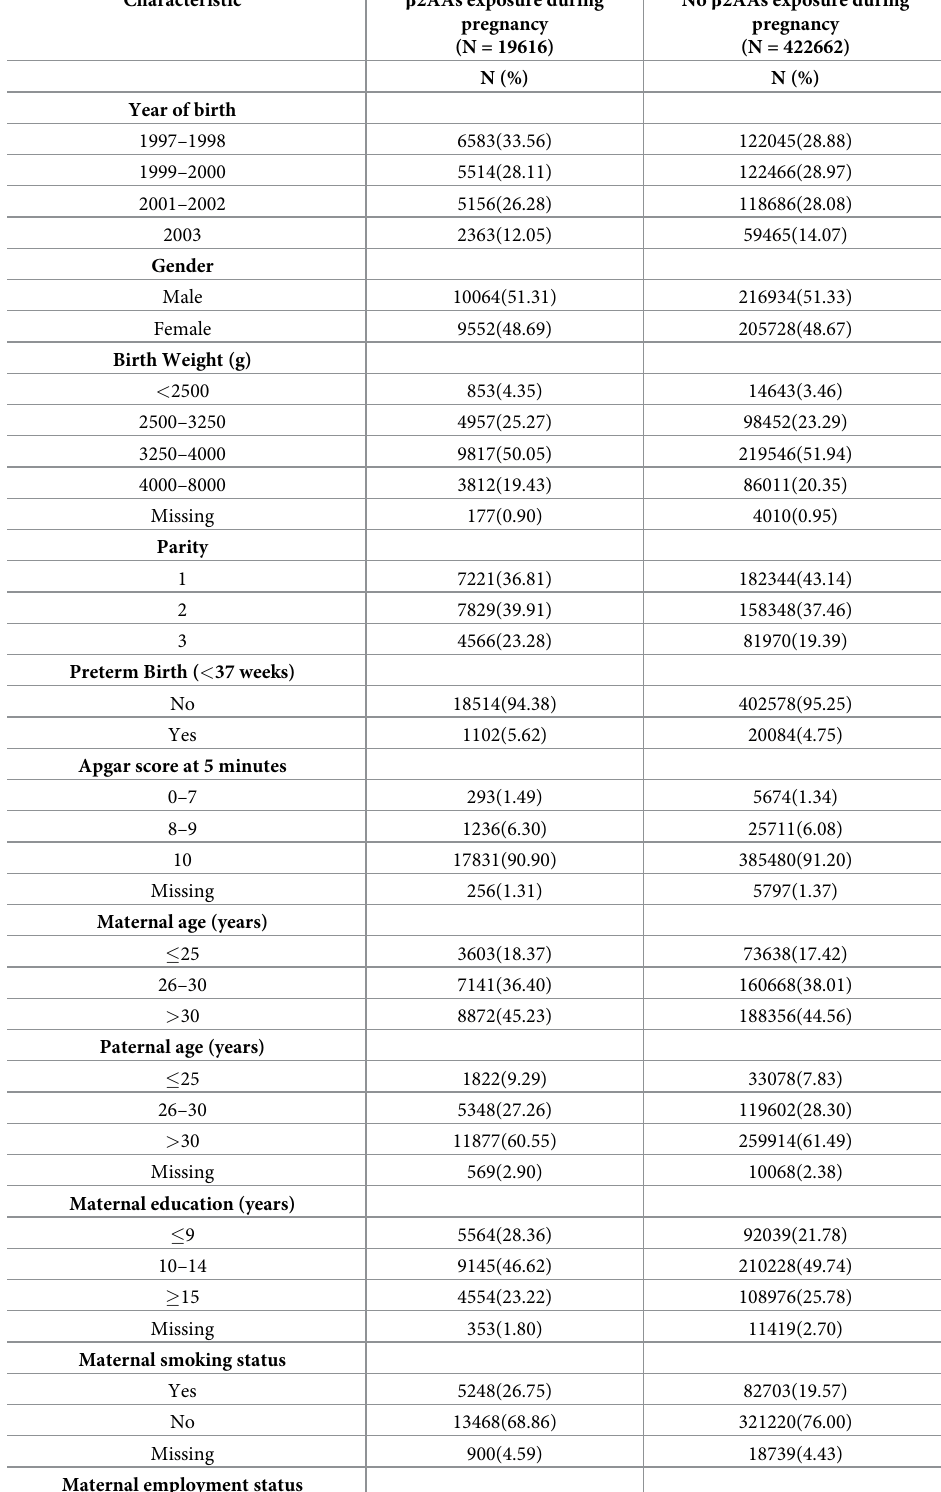
Table 1. Baseline characteristics of the study population according to β 2AAs usage during pregnancy.